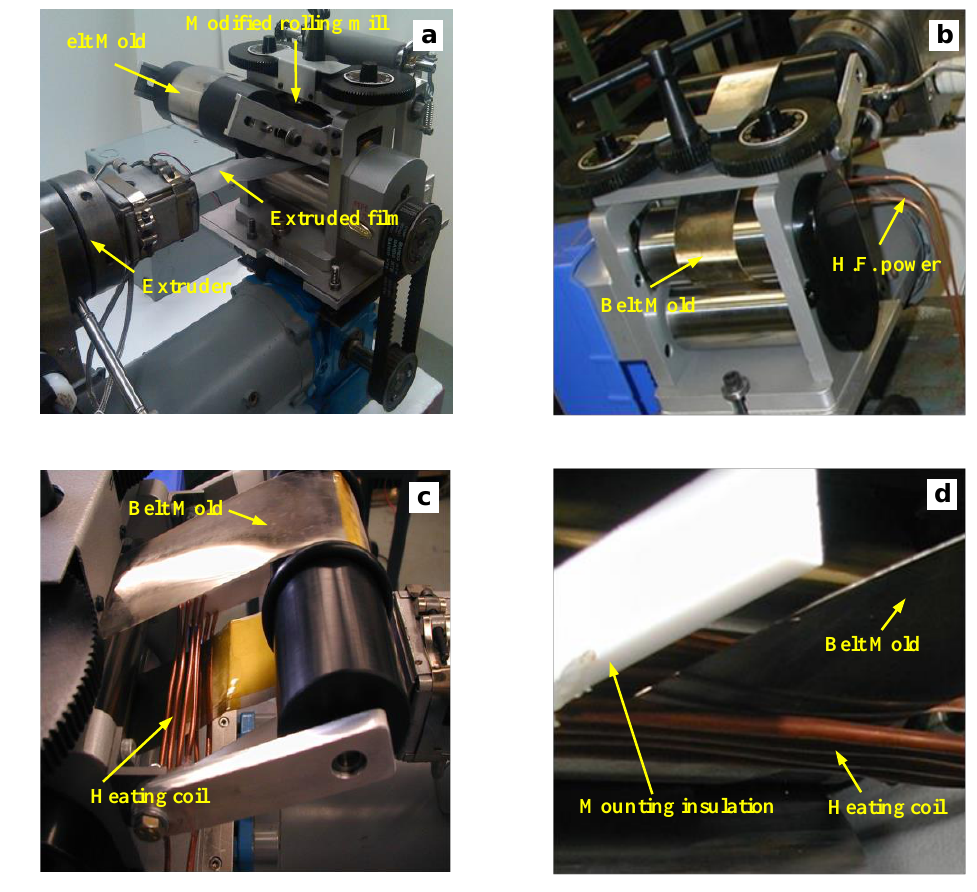
Figure 4. Experimental setup for variotherm extrusion roller imprinting: ( a ) view from the extruder side; ( b ) view from the rolling mill side; ( c ) belt mold and heating coil; ( d ) close view of heating